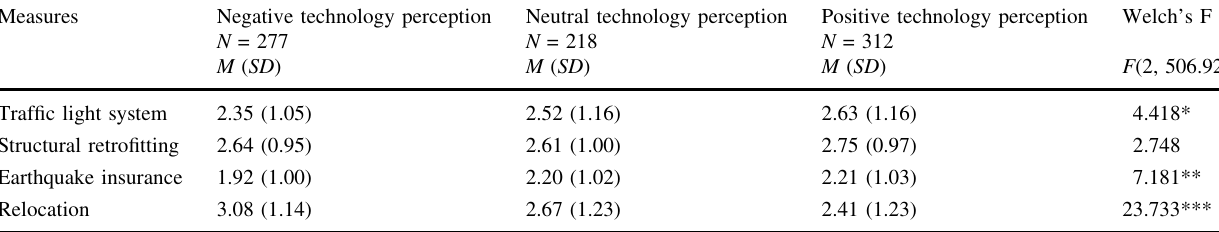
Values range from 1 = low preference to 4 = high preference